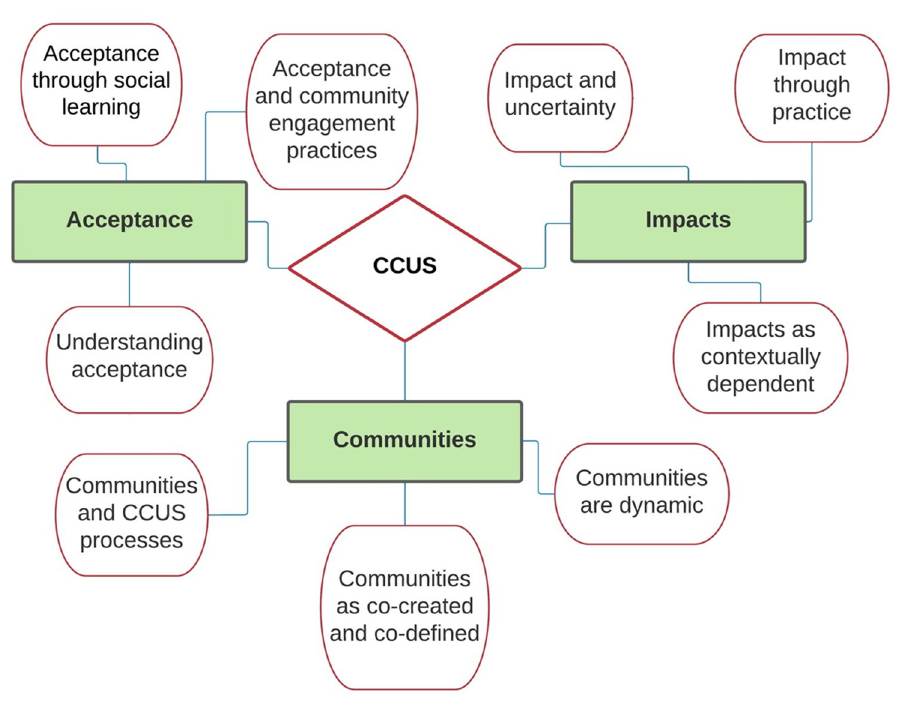
Fig 5. Review themes and